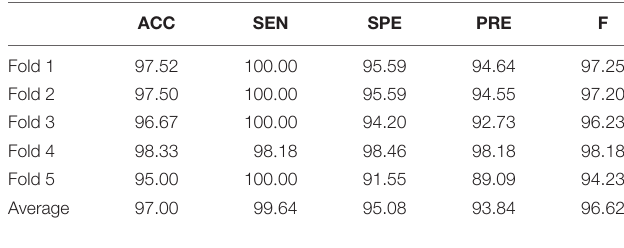
TABLE 3 | Performance of the PBTNet based on 5-fold cross-validation (unit: %).